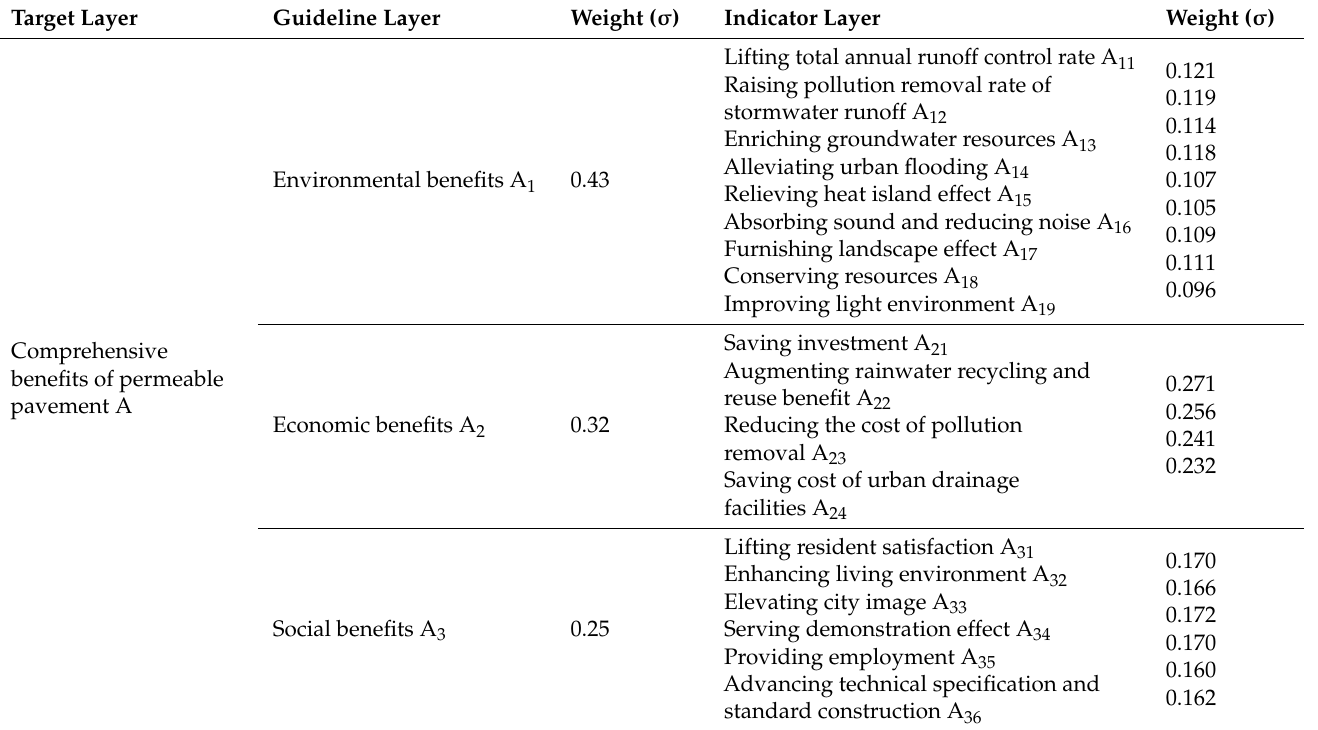
Table 3. The weight coefficients of the evaluation indicators.